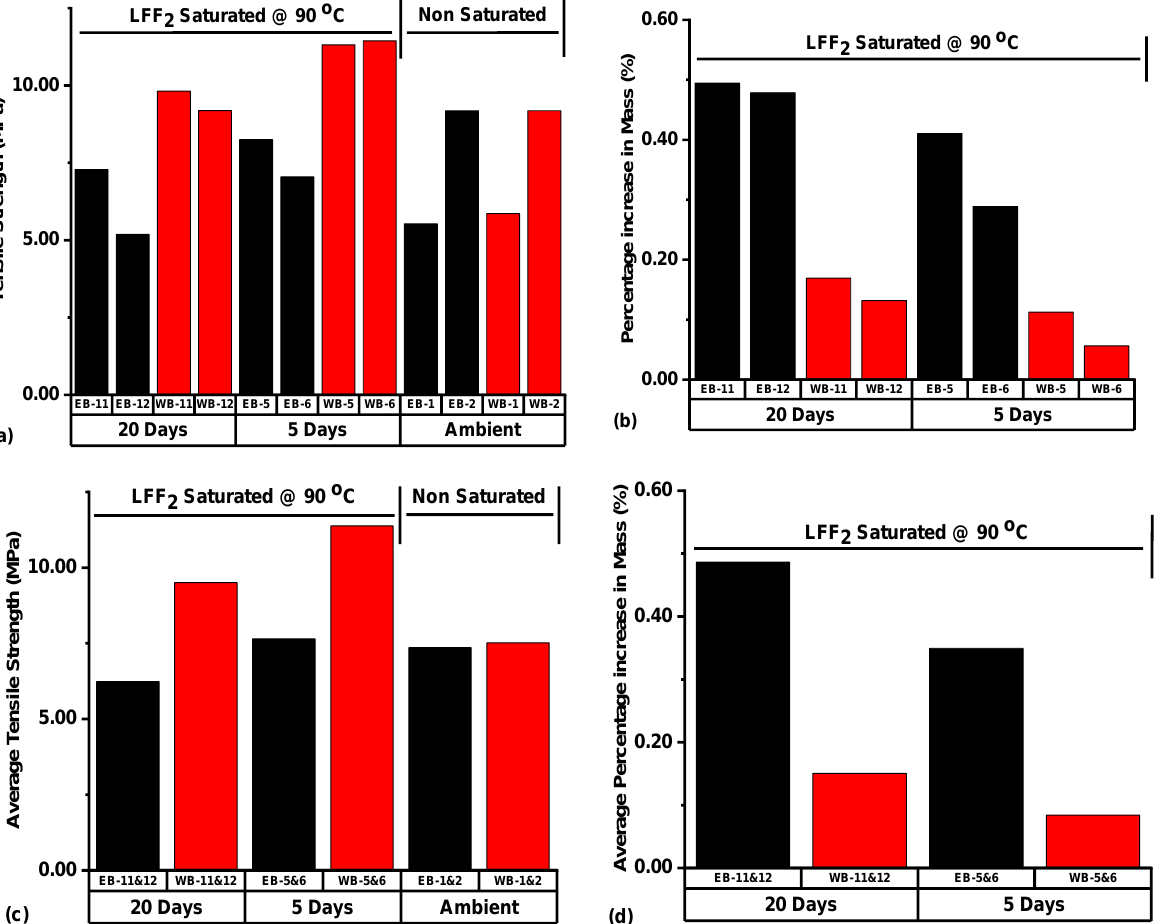
Figure 17. ( a ) Tensile strength, ( b ) Percentage increase in mass, ( c ) Average tensile strength (ATS), and ( d ) Average percentage increase in mass (APIM) distributions of samples subjected to diverse treatment conditions prior to BITS testing. The notes contained in Figure 14 still apply.